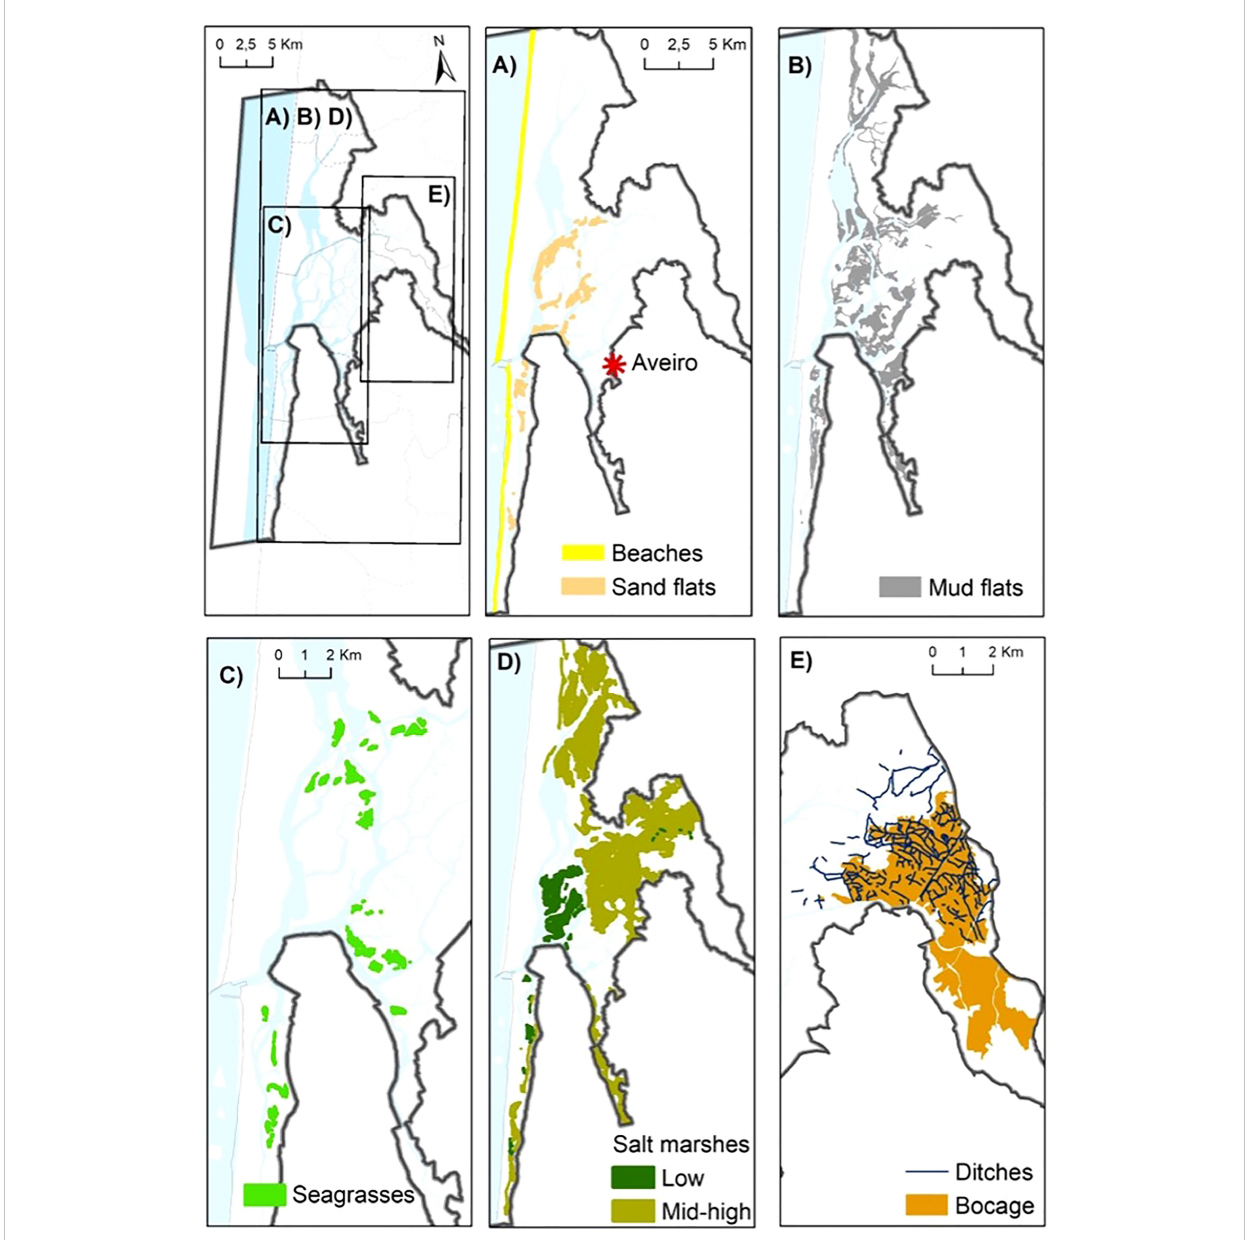
FIGURE 2 Selected habitats identi fi ed in the Ria de Aveiro: (A) beaches and sand fl ats, (B) mud fl ats, (C) seagrasses, (D) salt marshes (low and mid-high height) and (E) ‘ Bocage ’ with associated ditches. The Aveiro city (red asterisk), counties (dashed line) and the Special Protection Area (black line) are also